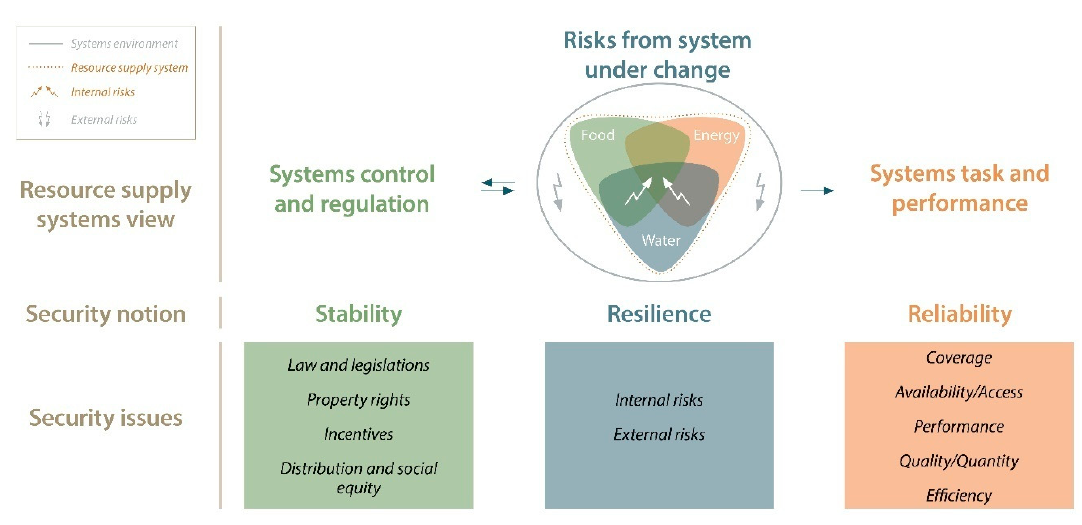
Figure 1. Resource supply security concepts.